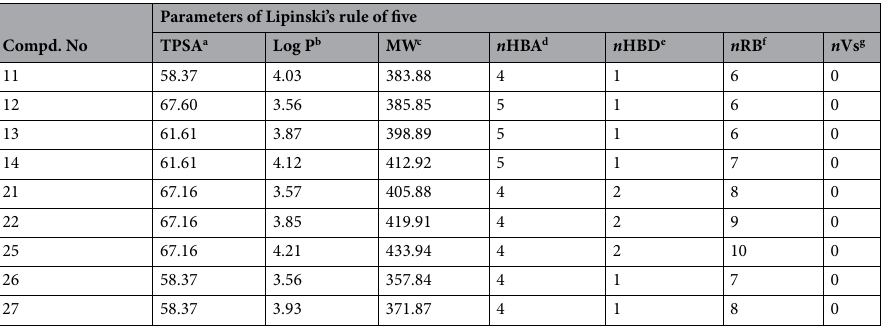
Table 4. Calculated parameters of Lipinski’s rule of five, its violation and drug-likeness for compounds 11–14, 21, 22 and 25–27. a Topological polar surface area, b Calculated lipophilicity, c Molecular weight. d Number of hydrogen bond acceptors, e Number of hydrogen bond donors, f Number of rotatable bonds. g Number of violation to Lipinski’s rule of five.